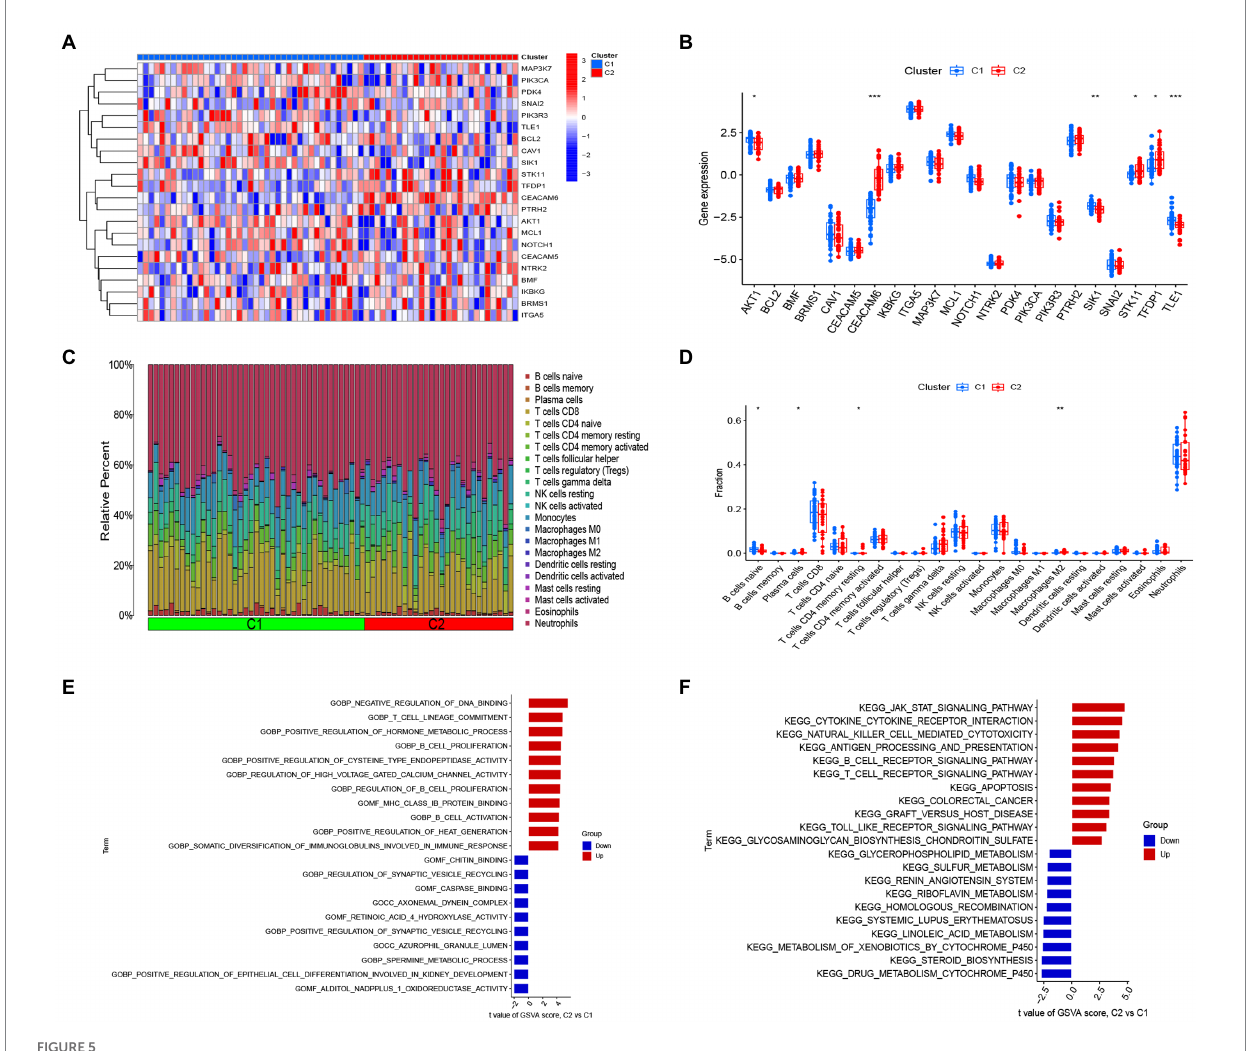
FIGURE 5 Identification of immune infiltration and biological functional characteristics in different clusters of anoikis. (A) Heat map showing the expression profiles of 22 anoikis-associated DEGs between two anoikis clusters. (B) Boxplot showing the difference in expression of 22 anoikis -associated DEGs between two anoikis clusters. (C) Relative abundance of 22 infiltrating immune cells between two lost apoptosis clusters. (D) Boxplot showing the difference in immune infiltration between two anoikis clusters. (E) GSVA results of the GO set between two anoikis clusters were plotted in the bar graph. (F) GSVA results of the KEGG gene set between two anoikis clusters are plotted in the bar graph. * p < 0.05, ** p < 0.01, *** p <